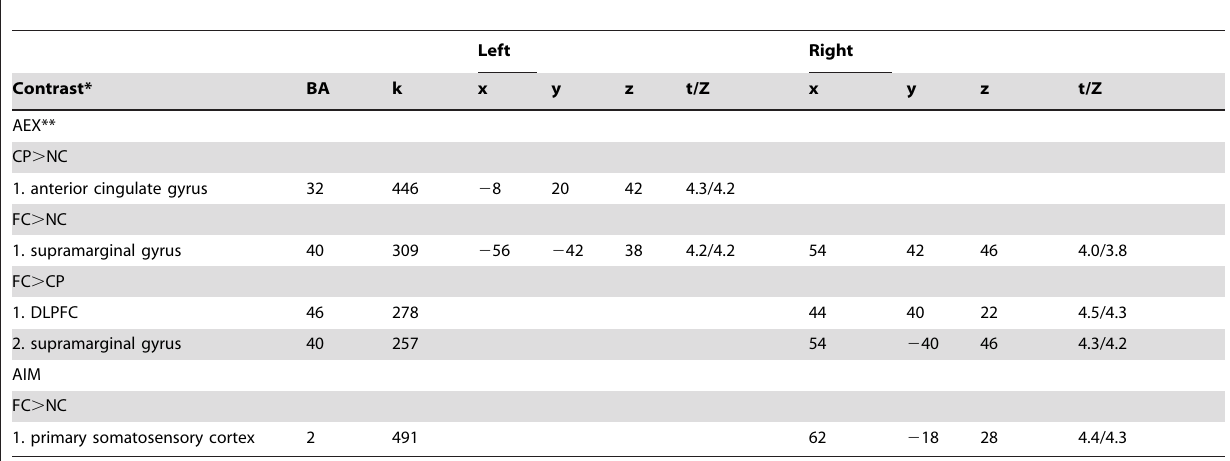
Table 4. Cerebral activation in between-group comparisons in unflipped data: hemisphere-specific activation.